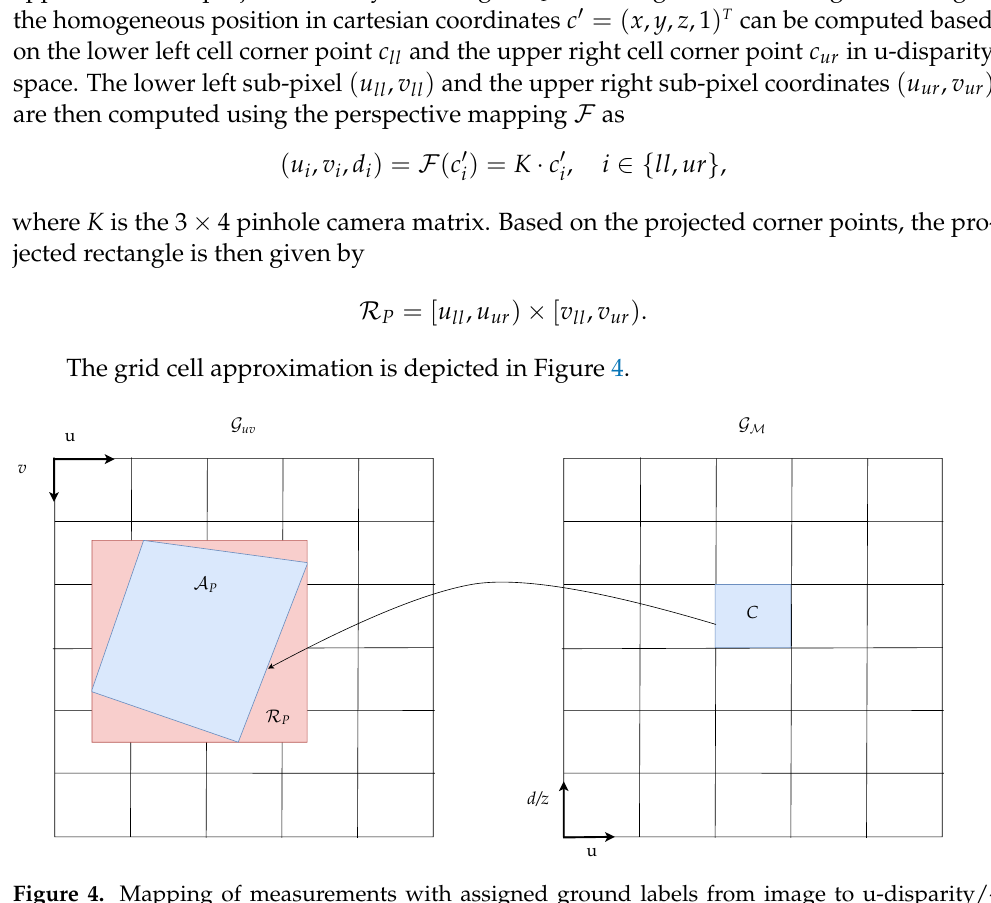
Figure 4. Mapping of measurements with assigned ground labels from image to u-disparity/- depth